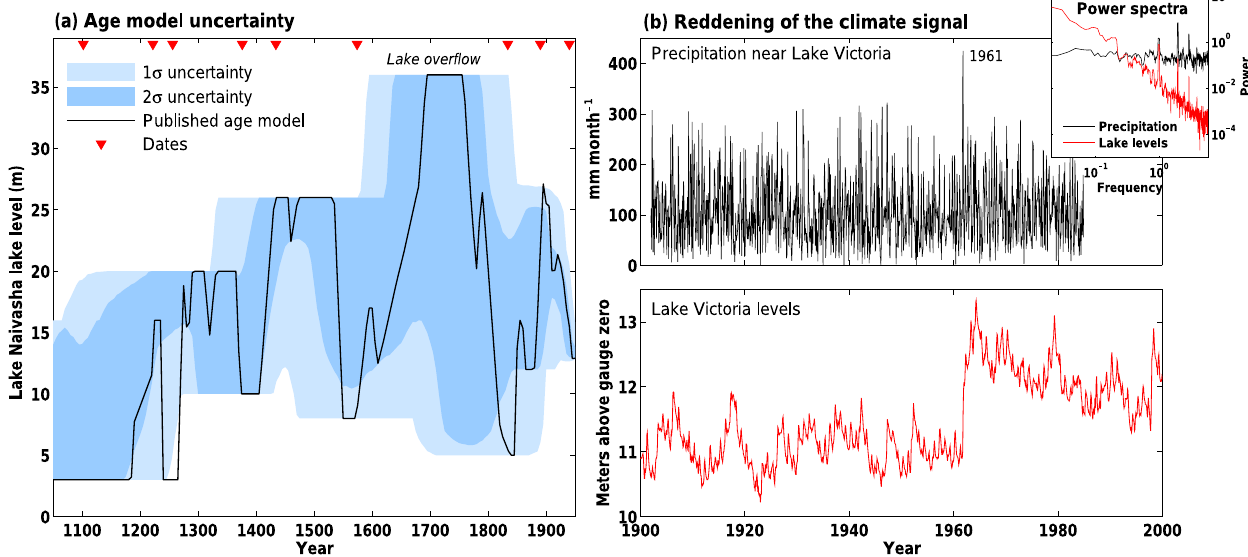
Figure 3. Examples of the effect of age model uncertainty and spectral reddening on paleoclimate signatures in sedimentary archives. (a) Age model uncertainty associated with the Lake Naivasha (East Africa) lake level record (Verschuren et al., 2000) spanning the last millennium. Data on the published age model are plotted in black. Blue regions represent the 1 σ and 2 σ uncertainty bounds for the dating of the data, applying a Monte Carlo method for iterating age model uncertainty (Anchukaitis and Tierney, 2013). Red triangles denote the locations of chronological constraints (dates). Note that the timing of lake overflow during the Little Ice Age may have occurred anytime between 1600 and 1800CE. Figure after Tierney et al. (2013). (b) Comparison of historical monthly precipitation (from the Global Historical Climatology Network; Peterson and Vose, 1997) and lake level data (from Stager et al., 2007) for Lake Victoria, East Africa. Both the precipitation and the lake level data are from Jinja, Uganda. Note the step-change response of lake level to an extreme rainfall event in 1961. Inset shows a comparison of the power spectra; note the loss of high-frequency and increase in low-frequency power in the lake level data compared to